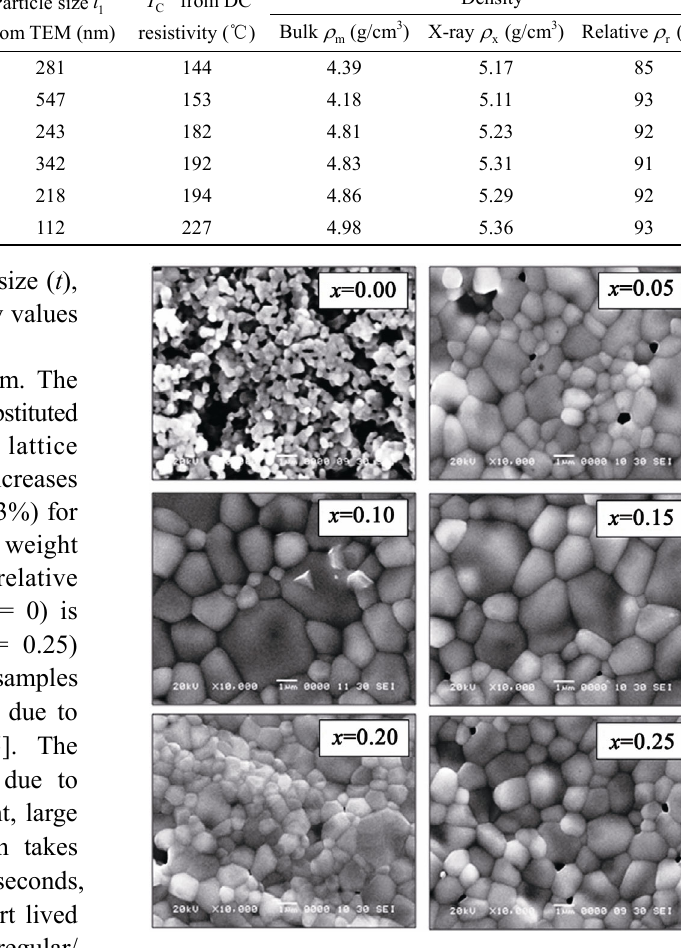
Fig. 2 SEM images of Mg 0.25– x Co x Cu 0.25 Zn 0.5 Fe 2 O 4 (0 ≤ x ≤ 0.25)